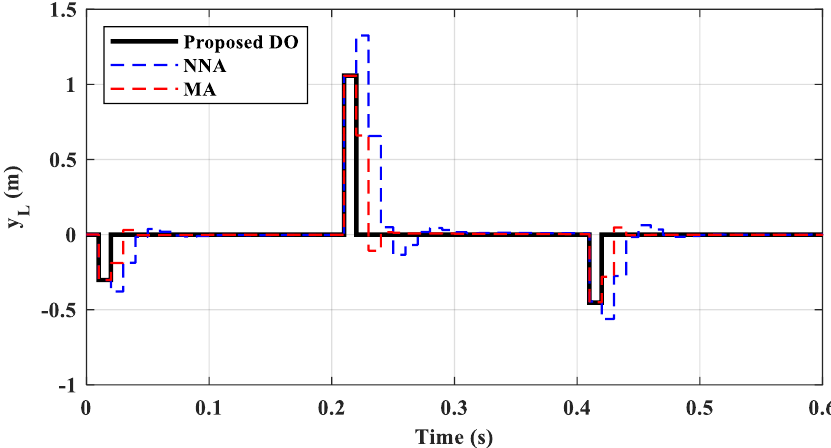
Figure 11. The output response of the AV lateral deviation against road curvature fluctuations.